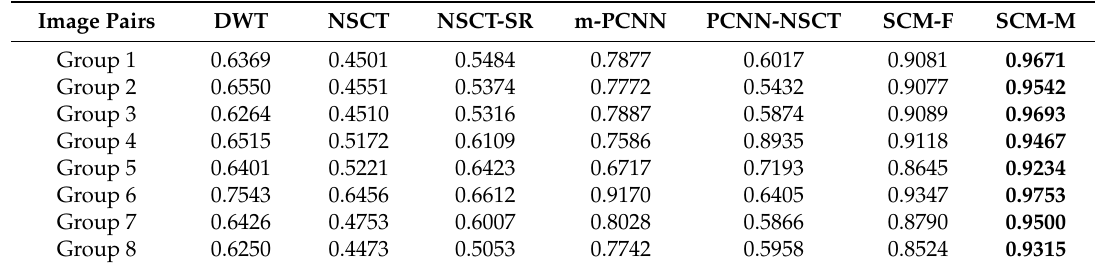
Table 3. Q S for the seven methods operating on the eight groups of medical images.